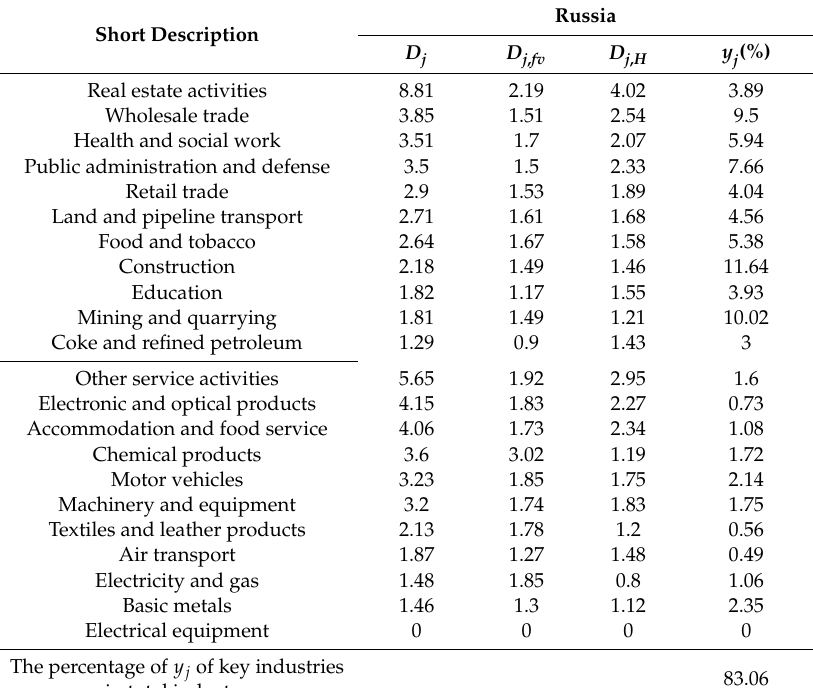
Table 3. Multiplicative SDA of EEI di ff erence of key sectors in Russia in